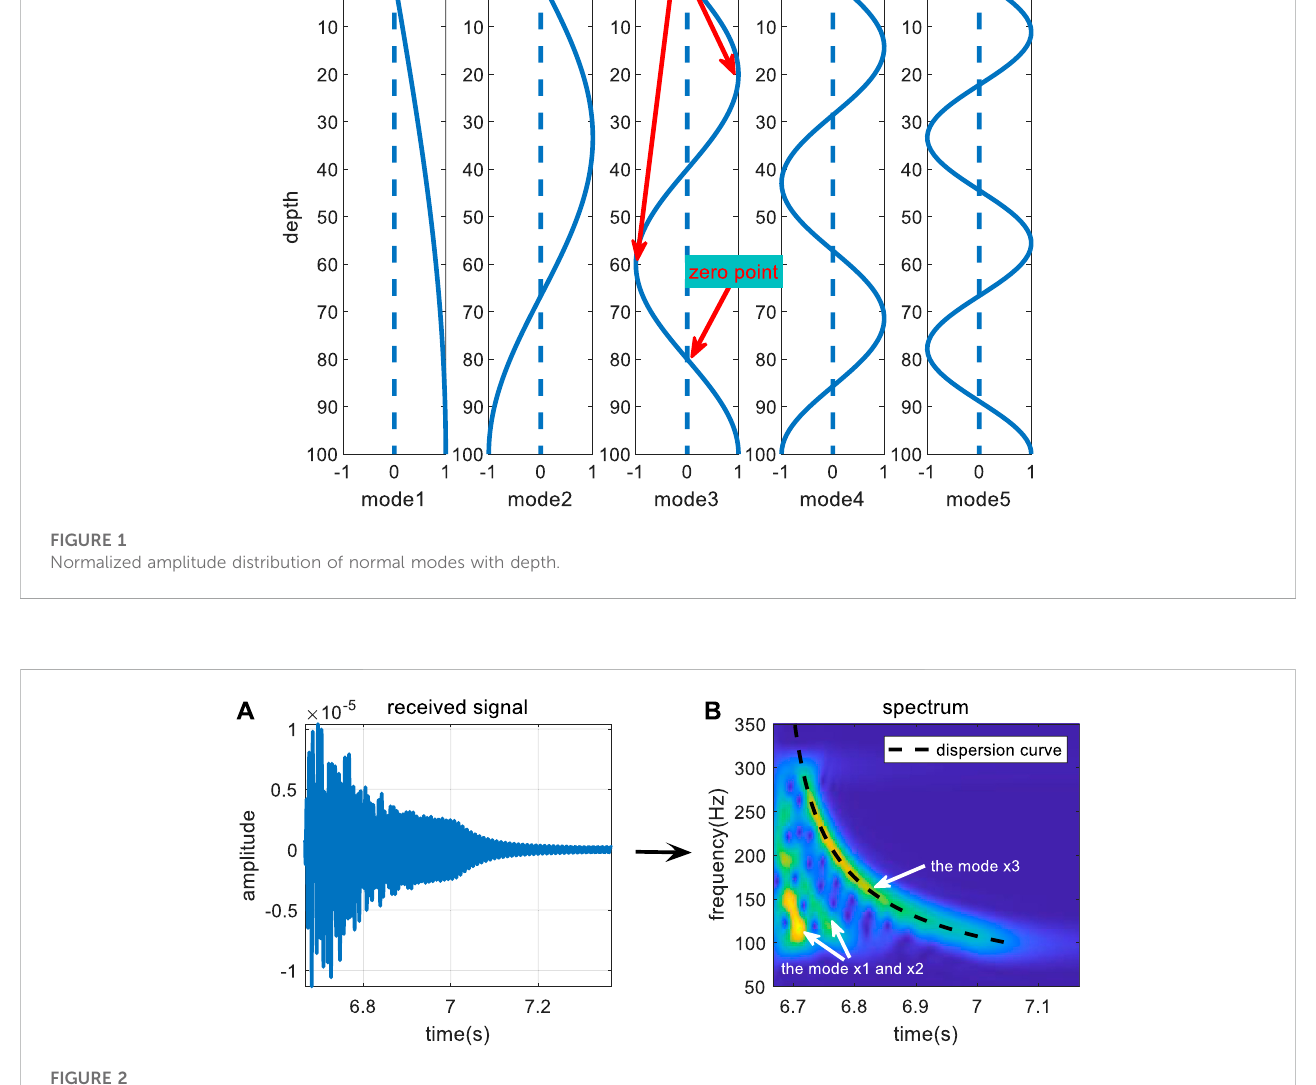
FIGURE 2 The received signal (A) in the time domain and (B) time-frequency